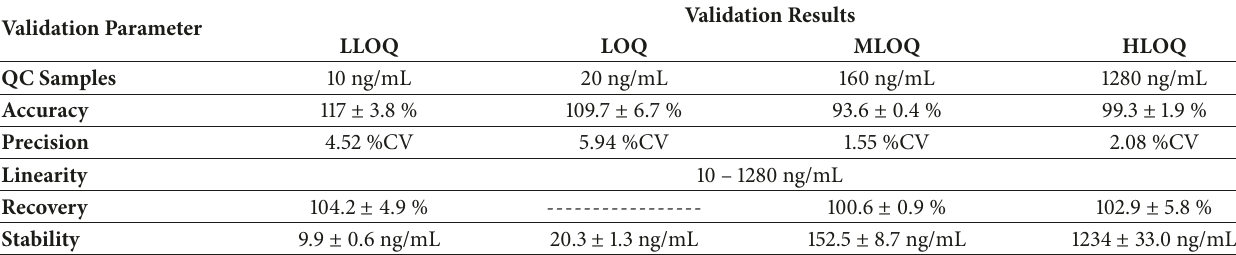
Table 2: Results of validation